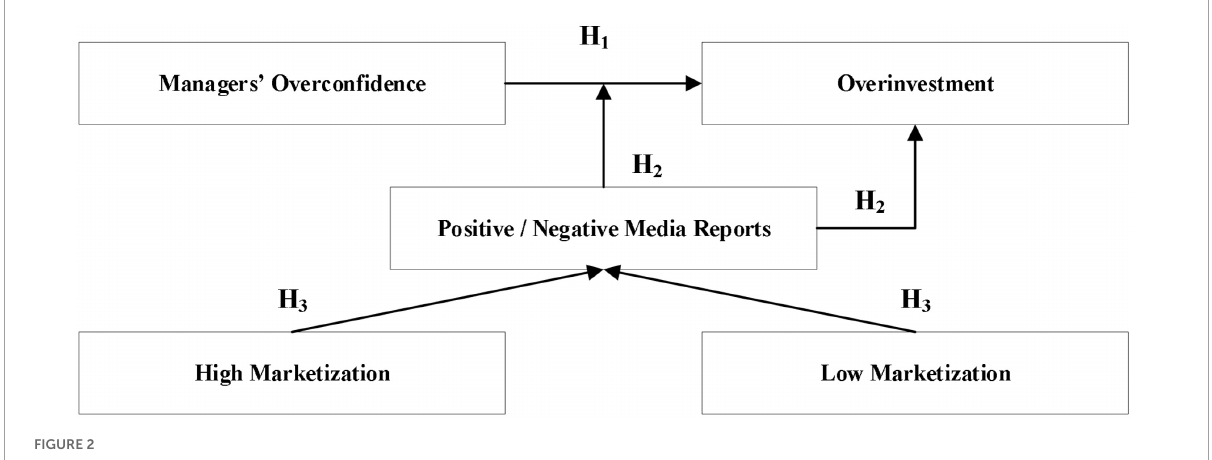
FIGURE2 Research hypothesis relationship